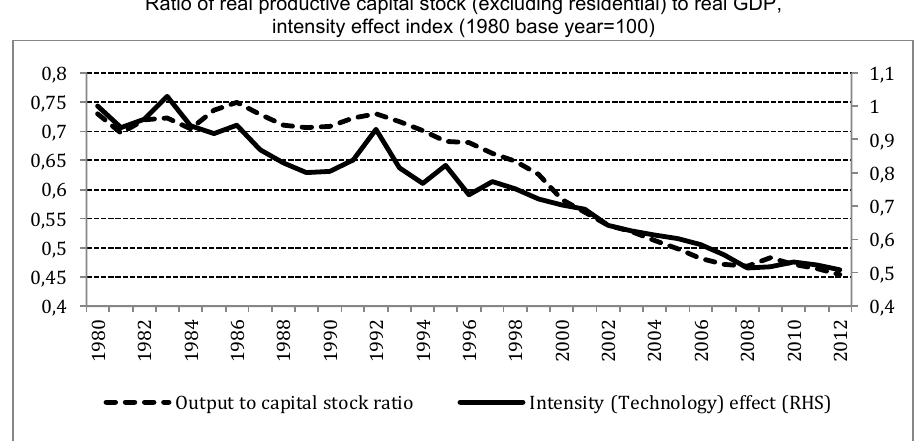
Figure 5 Capacity utilisation and the intensity